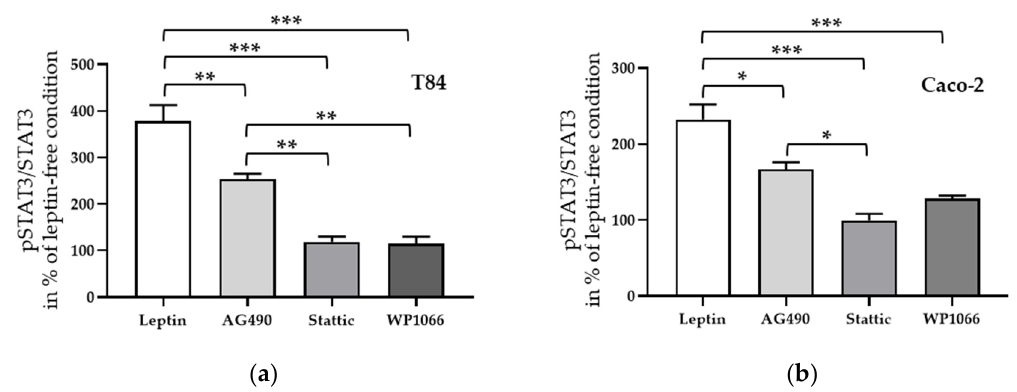
Figure 9. Effect of inhibitors on phosphorylated STAT3 to total STAT3 ratio in T84 ( a ) and in Caco-2 cells ( b ). * p < 0.05, ** p < 0.01, *** p < 0.001, n = 6–8.